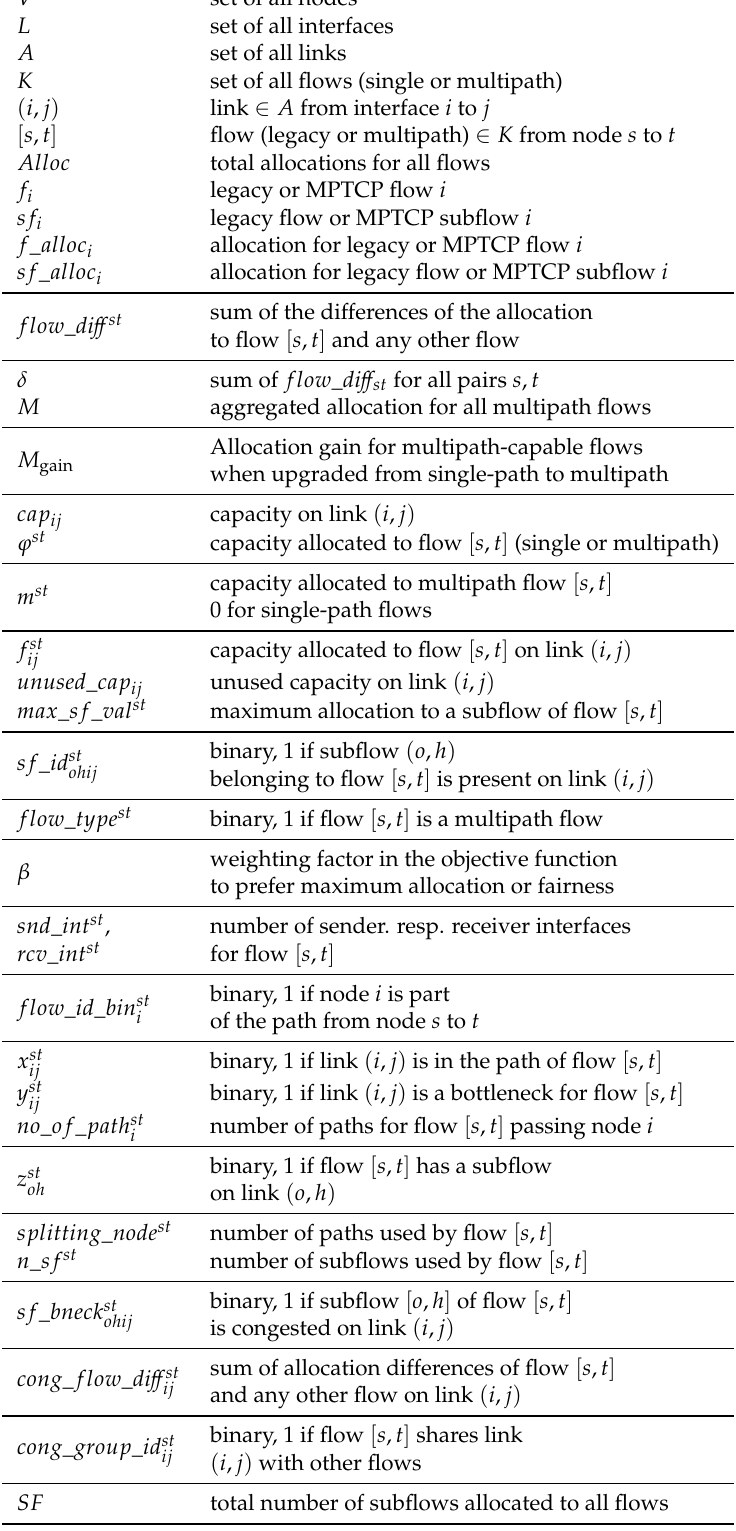
Table A1. Symbols used in the Mixed Integer Non-Linear Programming (MINLP)